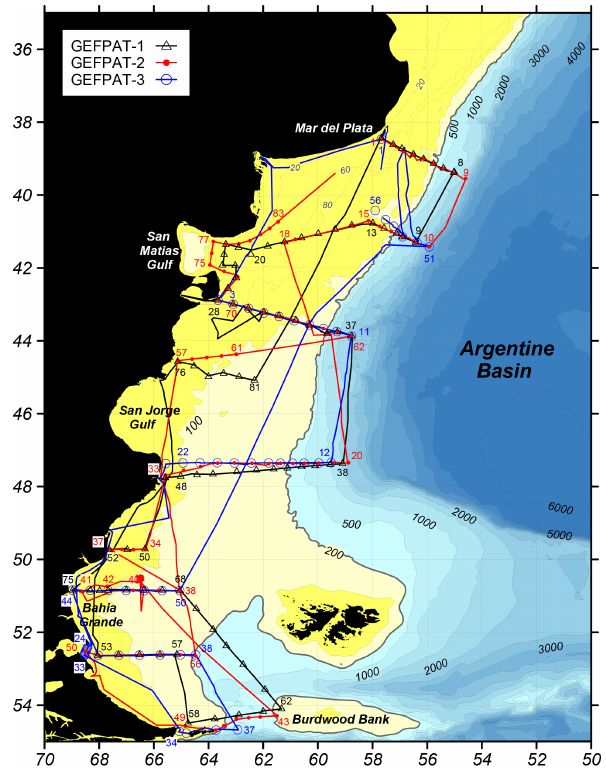
Figure 1. Location of hydrographic stations occupied during the GEF Patagonia cruises (symbols) and cruise tracks along which surface observations were collected (lines). Selected station num- bers for each cruise are shown in the same colors. The background shading and contours indicate bottom topography in